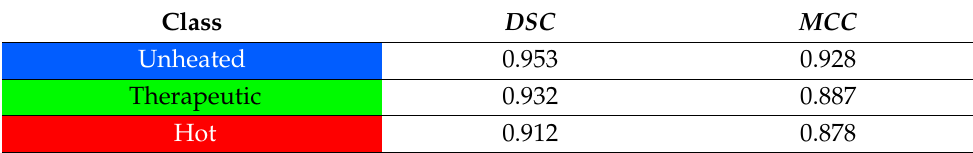
Table 1. DL-MWI Tumor CNN performance assessment.